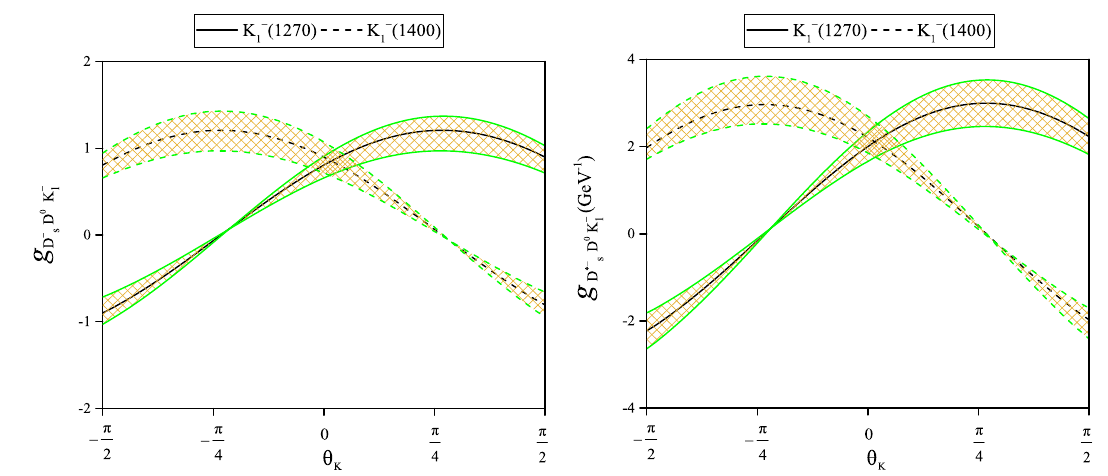
and g for K 1 = K 1 ( 1270 ), K 1 ( 1400 ) as a function of the mixing angle θ K as well as the D − s D 0 K − 1 D ∗− s D 0 K − 1